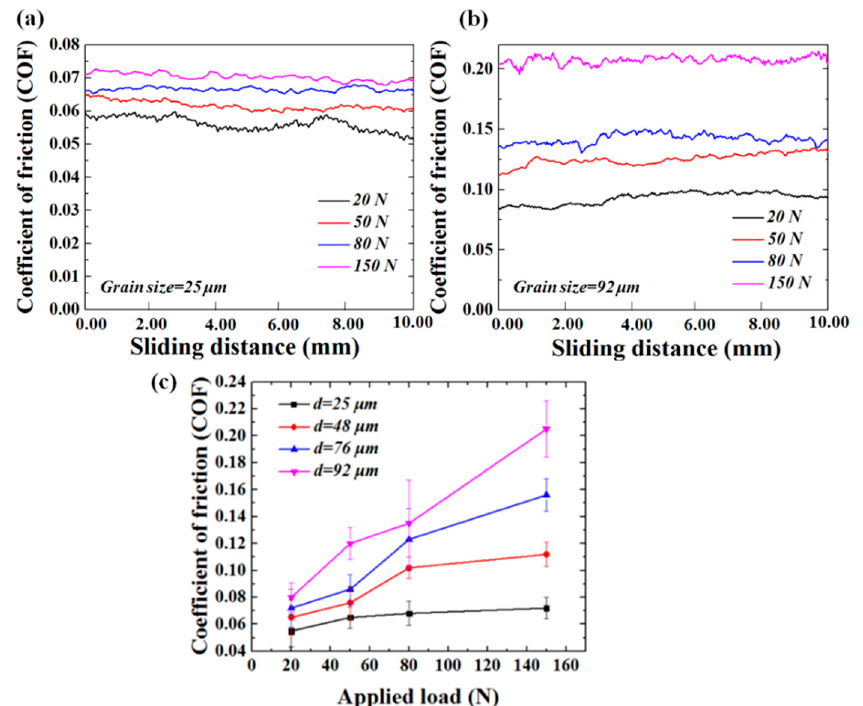
Figure 3. Variation of surface coefficient of friction (COF) with sliding distance of the 304 stainless steel sample with grain size of ( a ) 25 μ m and ( b ) 92 μ m at different applied loads. ( c ) Effect of grain size on the COF of the 304 stainless steels at different applied loads.